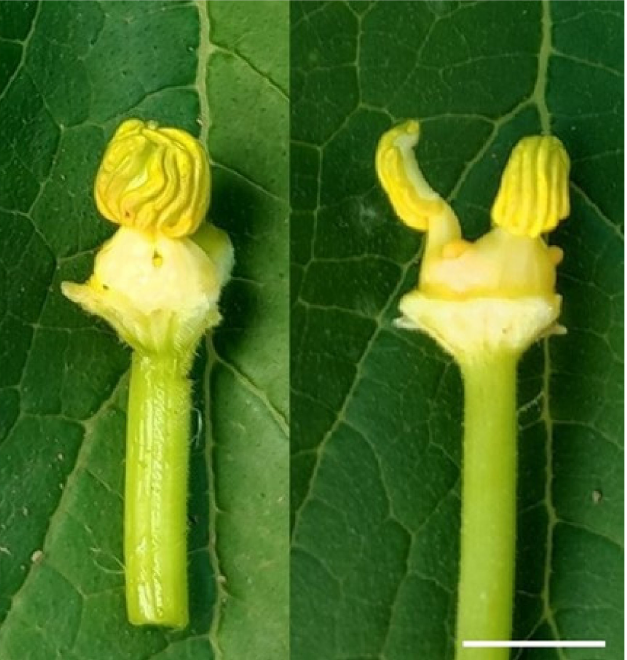
Figure 5. Abnormal male flowers of C. pepo (corolla removed). Scale bars = 1